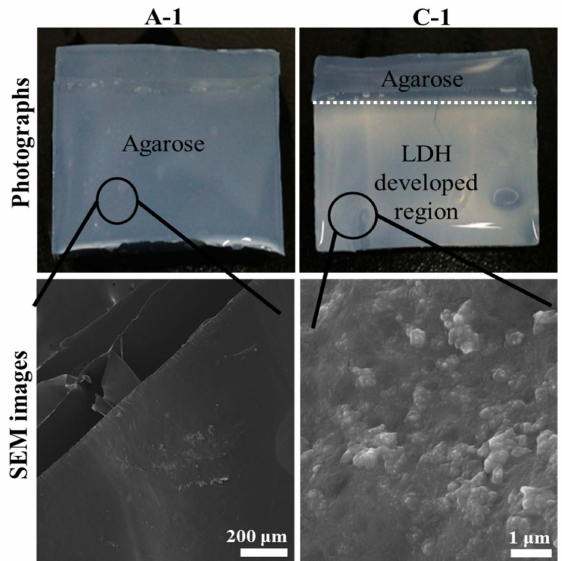
Figure 1. Photographs and scanning electron microscopic (SEM) images of agarose only hydrogel (1 wt/v% agarose concentration, A-1 ) and Layered double hydroxide (LDH)-agarose composite hydrogel (1 wt/v% agarose concentration, C-1 ). For SEM images, both A-1 and C-1 were dehydrated to